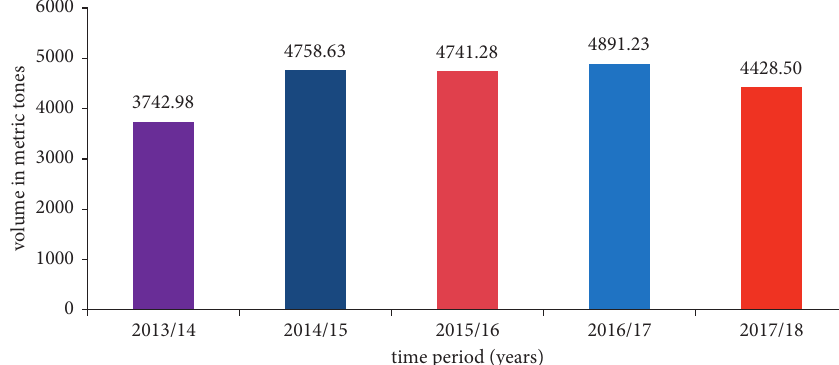
Figure 1: The volume of meat and meat products exported between 2013/14 and 2017/18. Source: